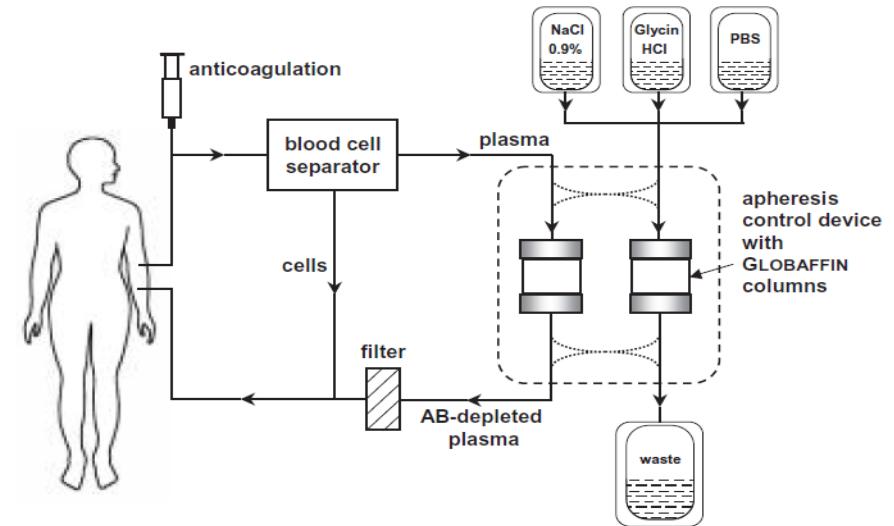
Figure 3. Principle of immunoadsorption. Principle of the immunoadsorption treatment. Reprinted from [68] with permission of John Wiley and Sons.